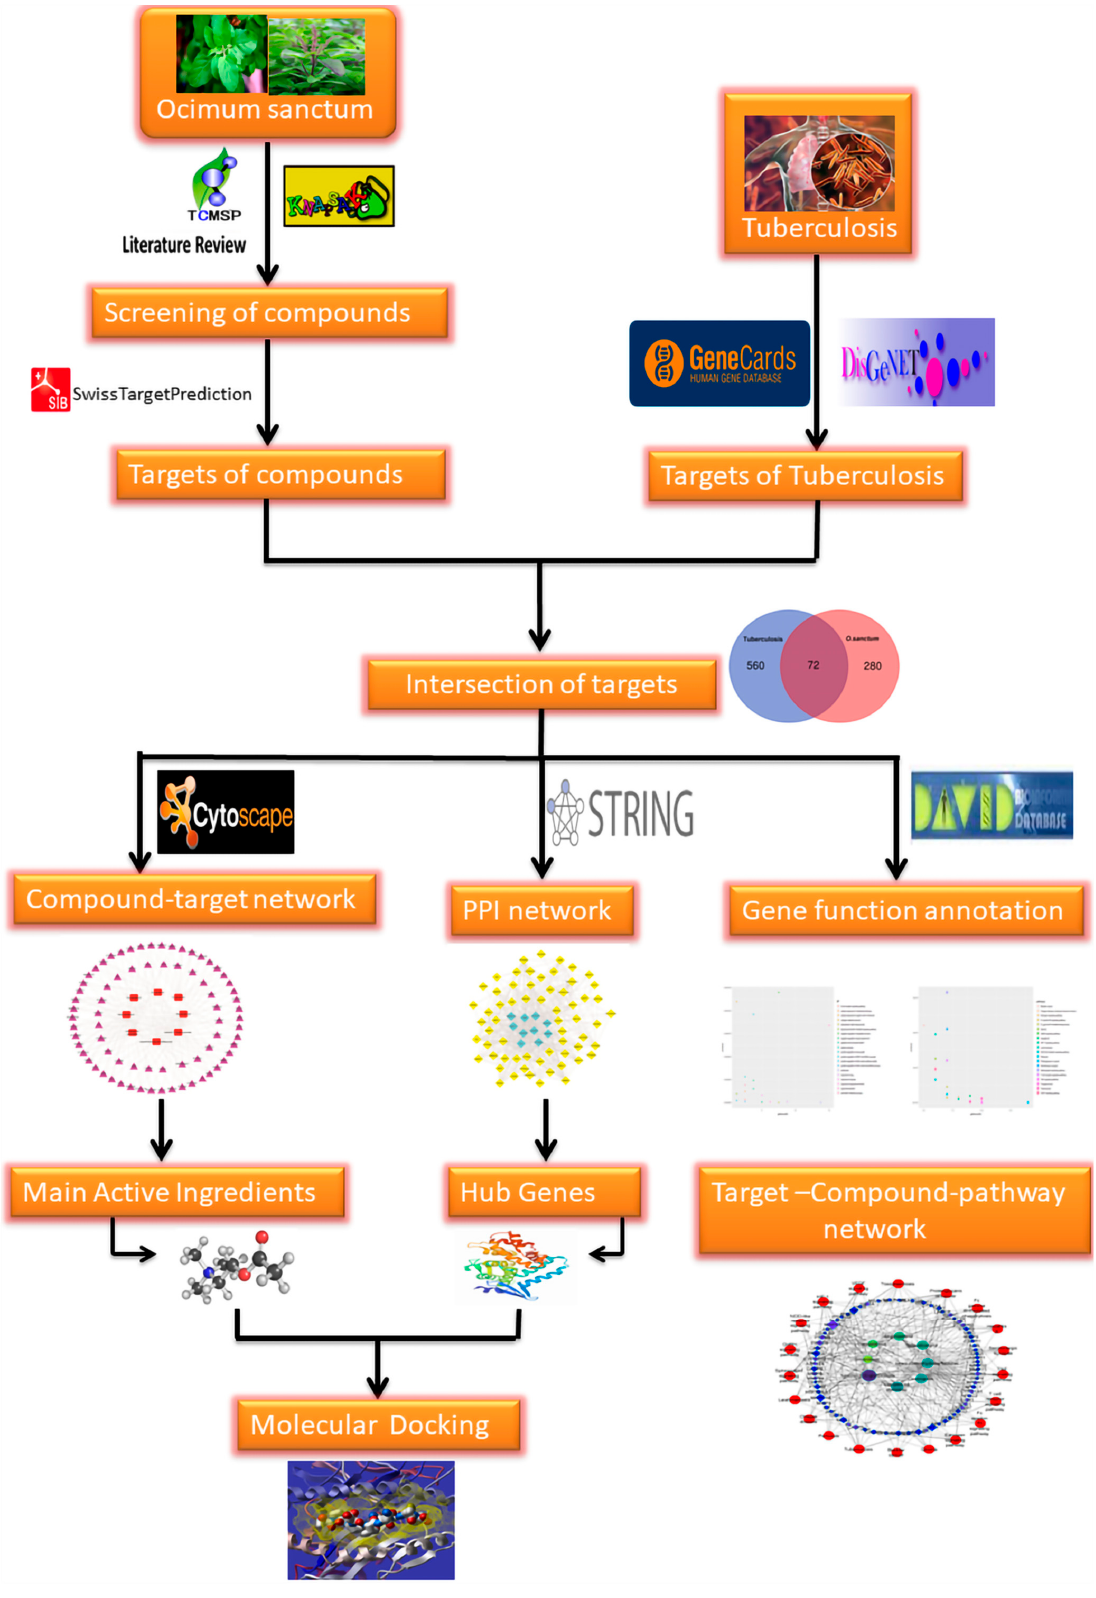
Figure 1. Schematic diagram of network pharmacology to explore mechanism of O. sanctum to treat